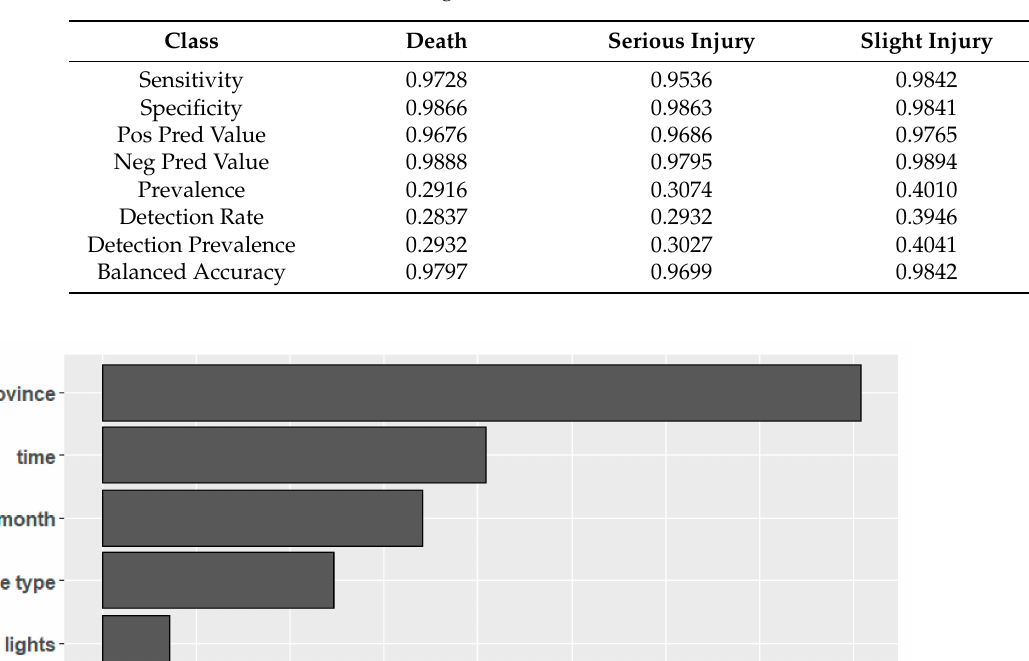
Table 8. Detailed measures of boosting tree model.